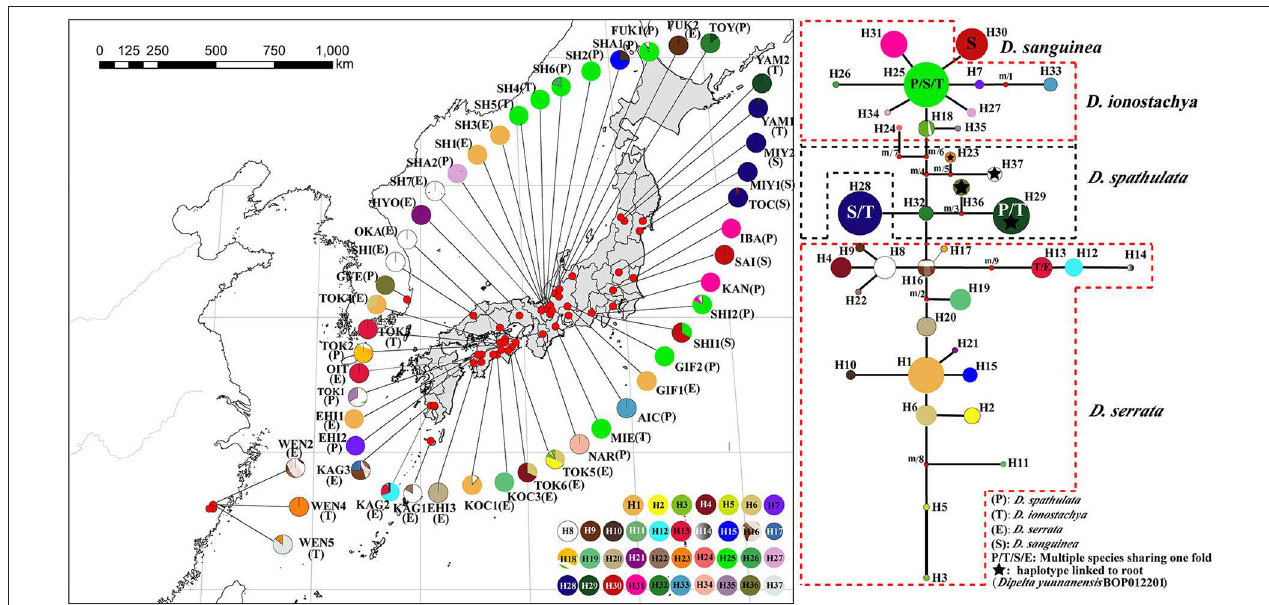
FIGURE 1 | Species range, geographical distribution of haplotypes, and phylogenetic relationship among four Diabelia species. Geographical distribution of 37 chloroplast haplotypes in sampled locations. Shading indicates the native range of each species (Hara, 1983; Landrein and Farjon, 2019). Four haplotypes (H13, H25, H28, and H29) are multiple species shared haplotypes, of which H25 is shared haplotype of D. ionostachya, D. sanguinea, and D. spathulata . H13 is the shared haplotype for D. ionostachya and D. serrata ; H28 is the shared haplotype for D. ionostachya and D. sanguinea ; H29 is the shared haplotype for D. ionostachya and D. spathulata ,